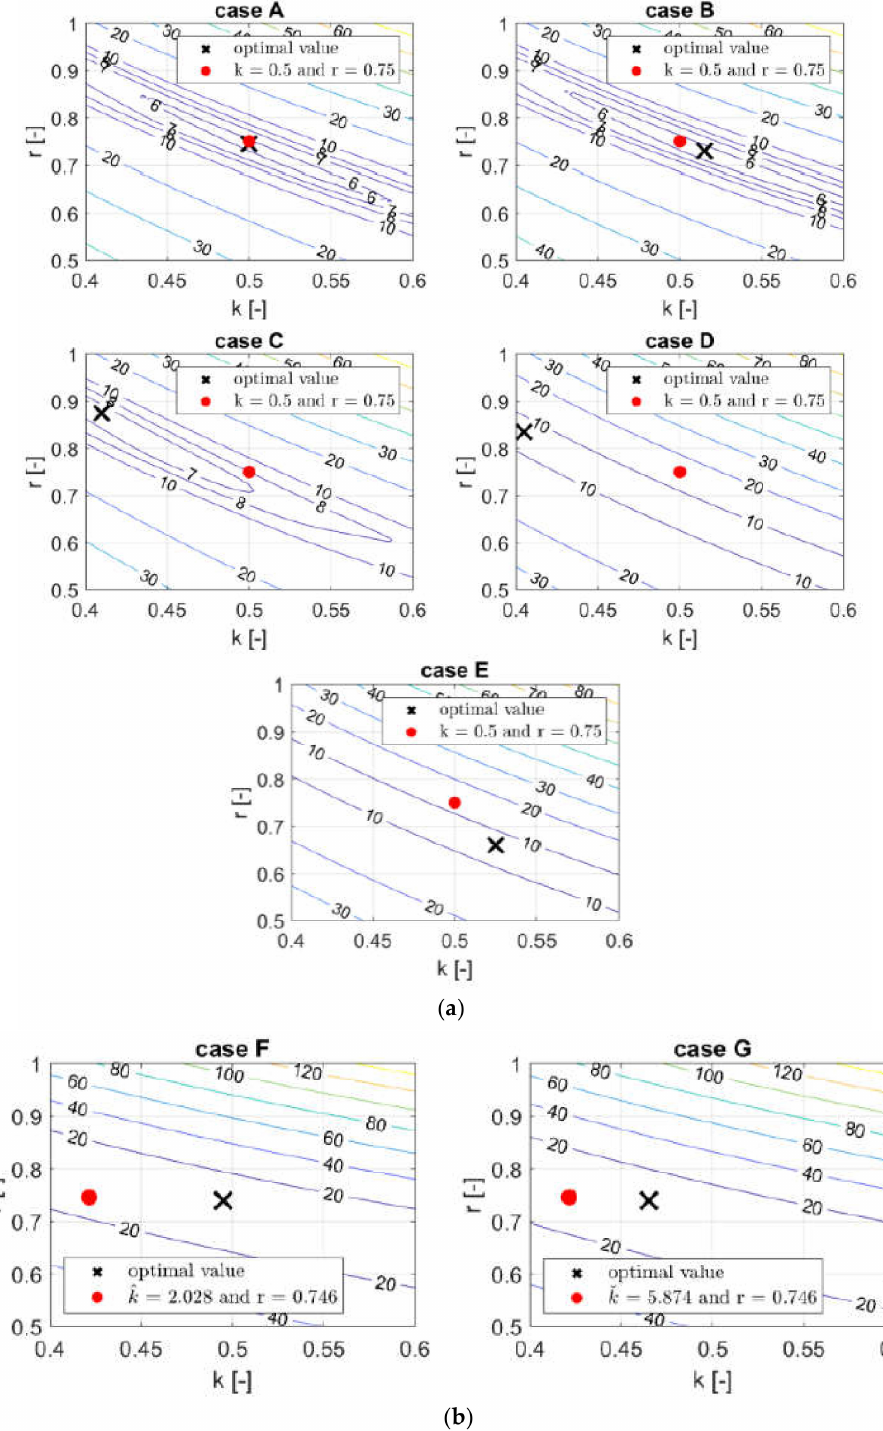
Figure 4. Contour plots of the mean error obtained for cases A–G for: ( a ) k and r (cases A–E) and ( b ) ˆ k ( k , r ) or ˇ k ( k , r ) and r (cases